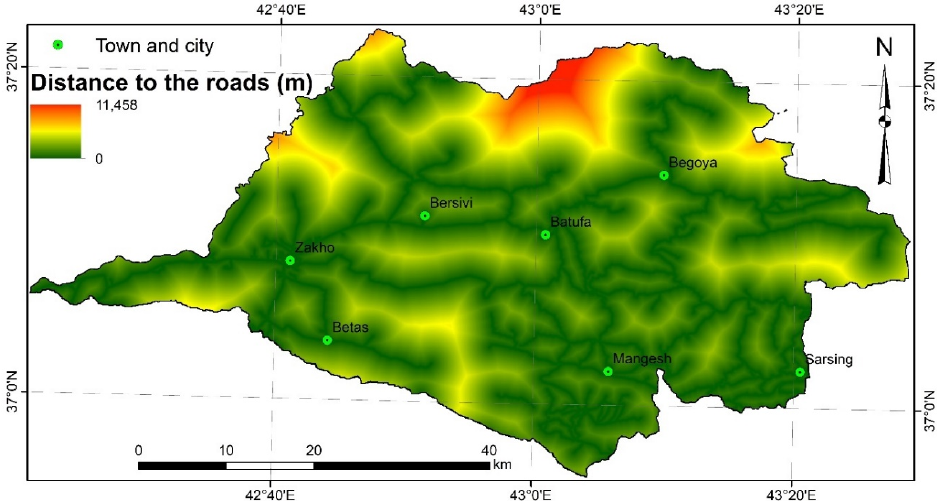
Figure 11. Map of distance to road.